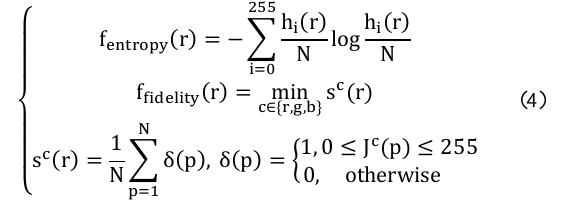
Figure 3. Flow chart of pre-processing underwater images for 3D reconstruction